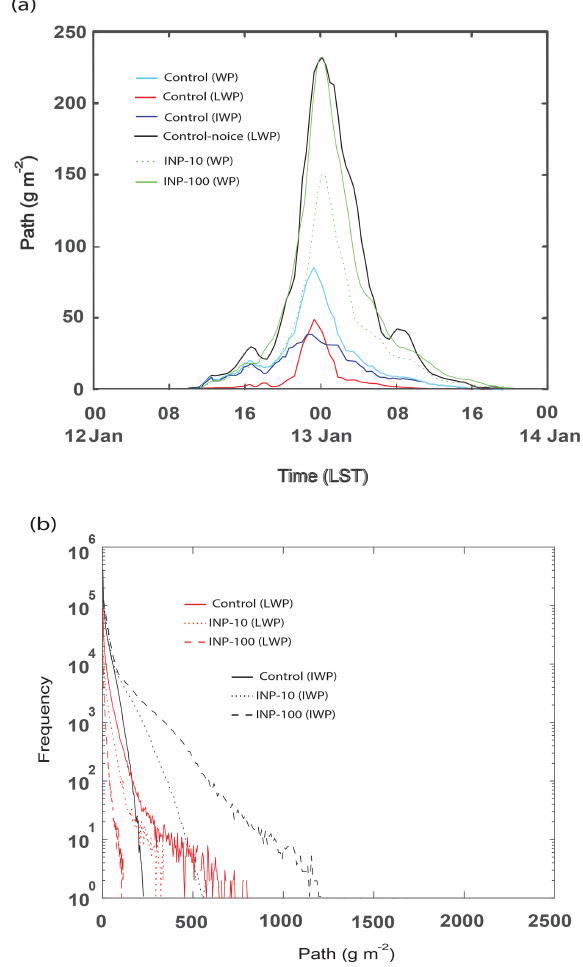
Figure 9. (a) Time series of the domain-averaged LWP, IWP, and WP for the control run; LWP for the control-noice run; and WP for the INP-10 and INP-100 runs. (b) Cumulative frequency of LWP, IWP, and WP for the control, INP-10, and INP-100 runs at the last time